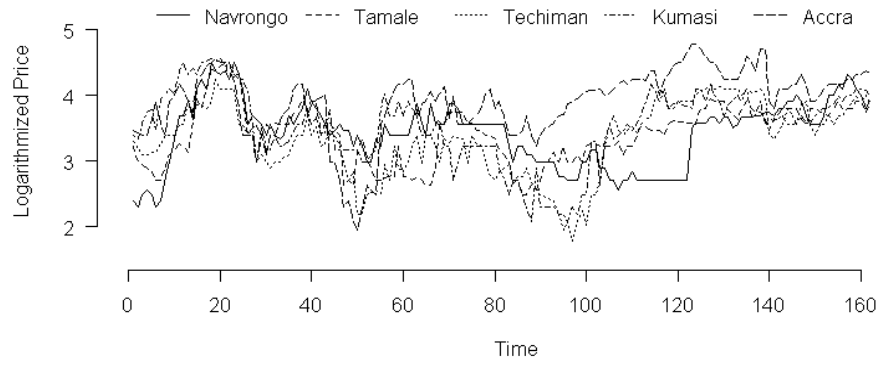
FIGURE 1: High Frequency, Semi-weekly Price Data (in Ghana Cedi) Source: